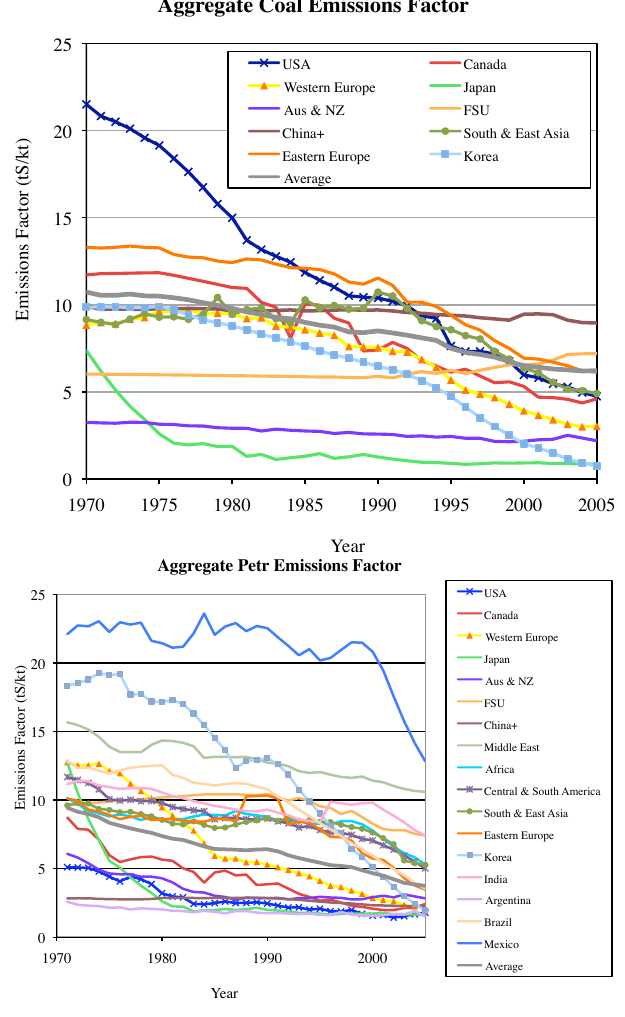
Fig. 7. Aggregate emissions factors for (a) coal and (b) petroleum combustion by region.